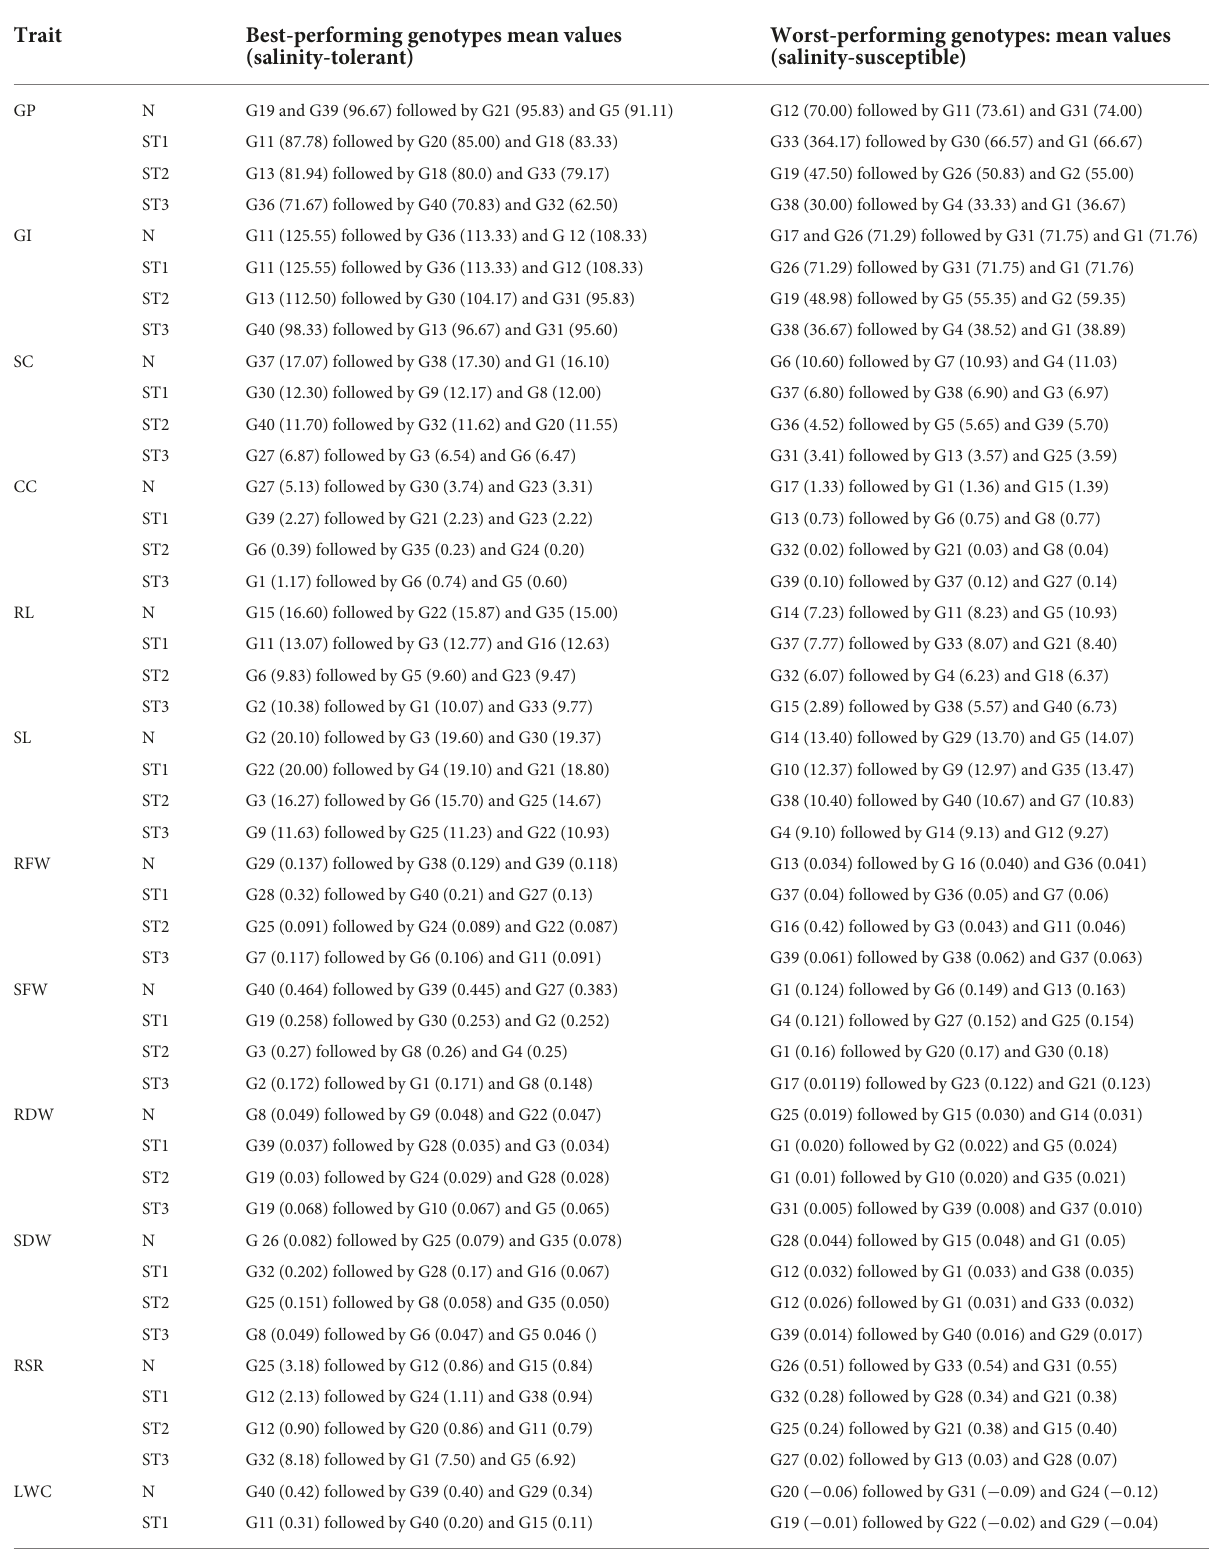
TABLE 2 Performance of wheat genotypes under salinity stress. Trait Best-performing genotypes mean values (salinity-tolerant)